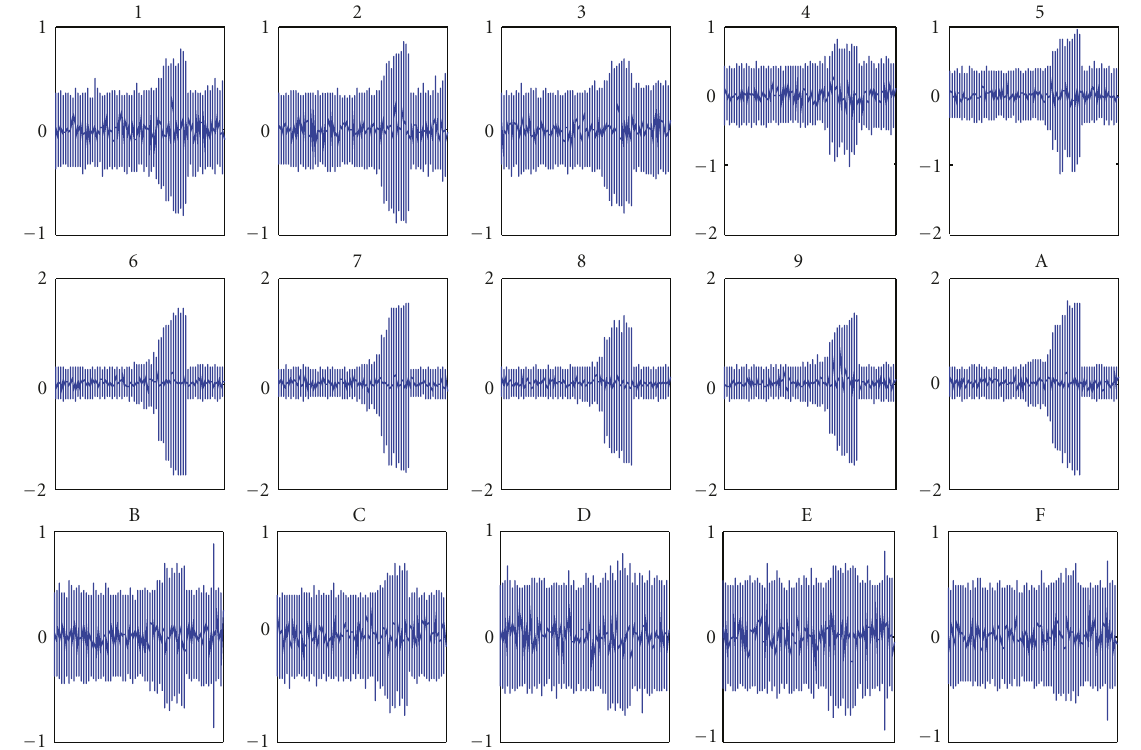
Figure 9: Signals (amplitude versus time) collected from the 15 microphones with a duration of 30 seconds for each signal.